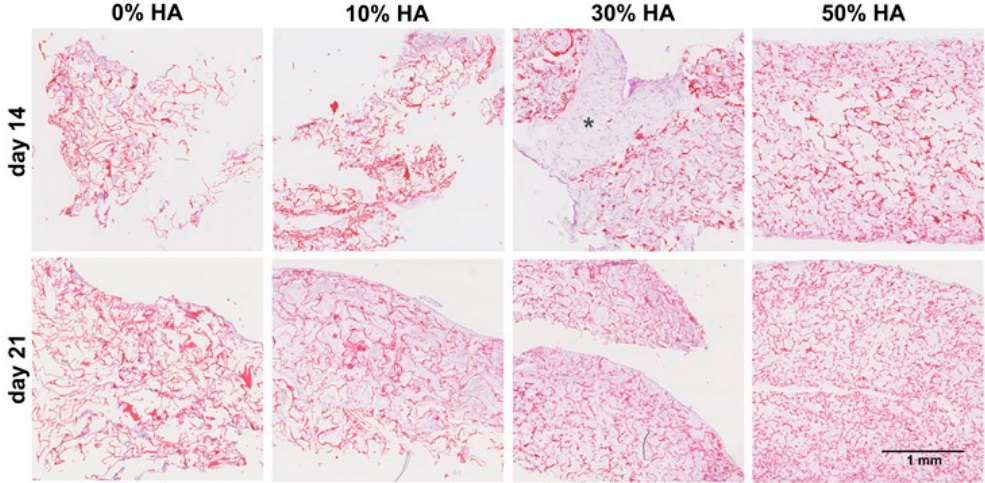
Figure 3. Histology of hMSCs cultured after 14 and 21 days. Hematoxylin-eosin staining of hMSCs- scaffold constructs after 14 and 21 days of culture. Positive influence of 30% of hydroxyapatite can be observed by large amount of newly-formed tissue with respect to the other scaffolds after 14 days of culture, designated by asterisk (*).